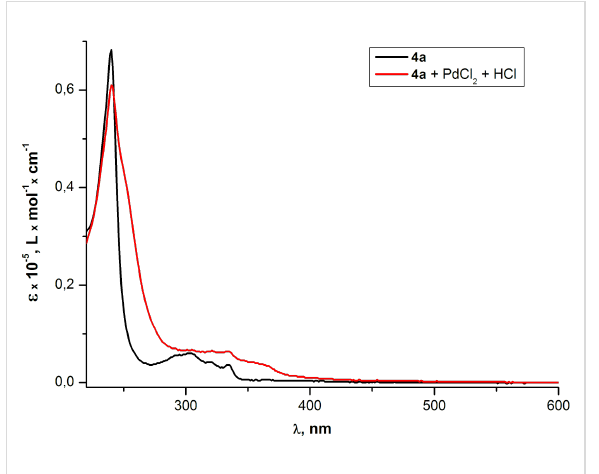
Figure 16: Optical absorption spectra of cinnoline 4a in THF before and after the addition of aqueous solution of PdCl 2 .